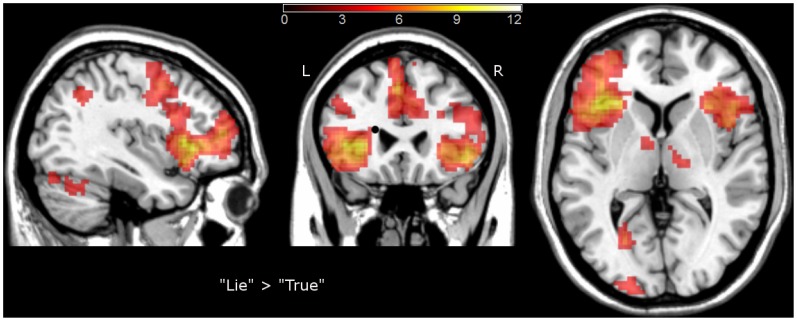
Brain regions showing increased activity during lying compared to truth-telling.The activations are superimposed on a Colin27 template image in the MNI space. The colored bar represents t-values; L – left side; R- right side.